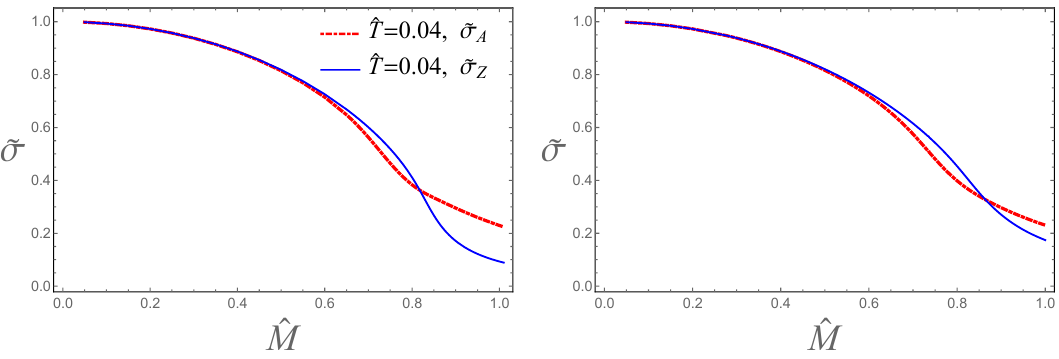
Figure 12. The transport parameters as a function of ˆ M ( ≡ ˆ M 1 = ˆ M 2 , i.e. the diagonal line in the phase diagram.) at c/b = 1 , T/b = 0 . 04 , with q 1 = 1 , λ 1 = 1 / 10 , q 2 = 3 / 2 , λ 2 = 1 / 2 ( left ), and with q 1 = 1 , λ 1 = 1 / 10 , q 2 = 13 / 10 , λ 2 = 45 / 100 ( right